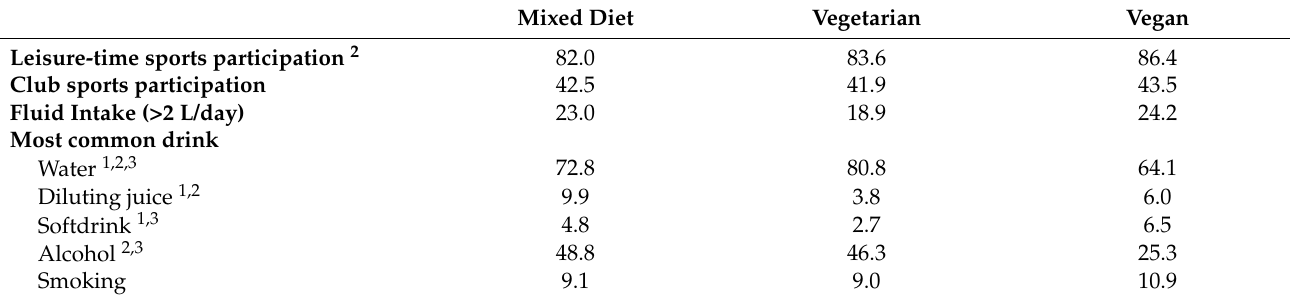
Table 8. Health behaviors by dietary pattern. Values are in prevalence